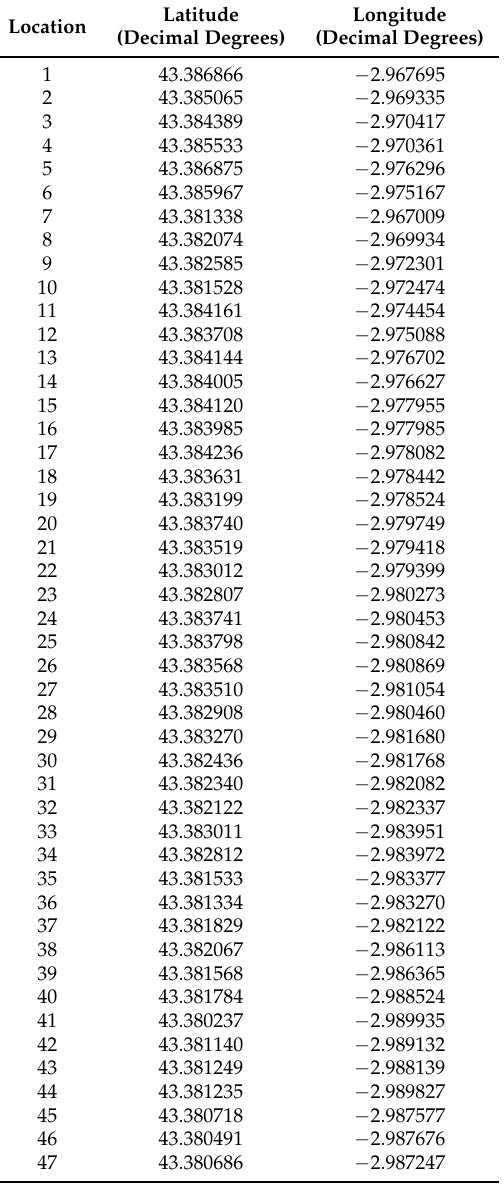
Table A5. Coordinates of the 147